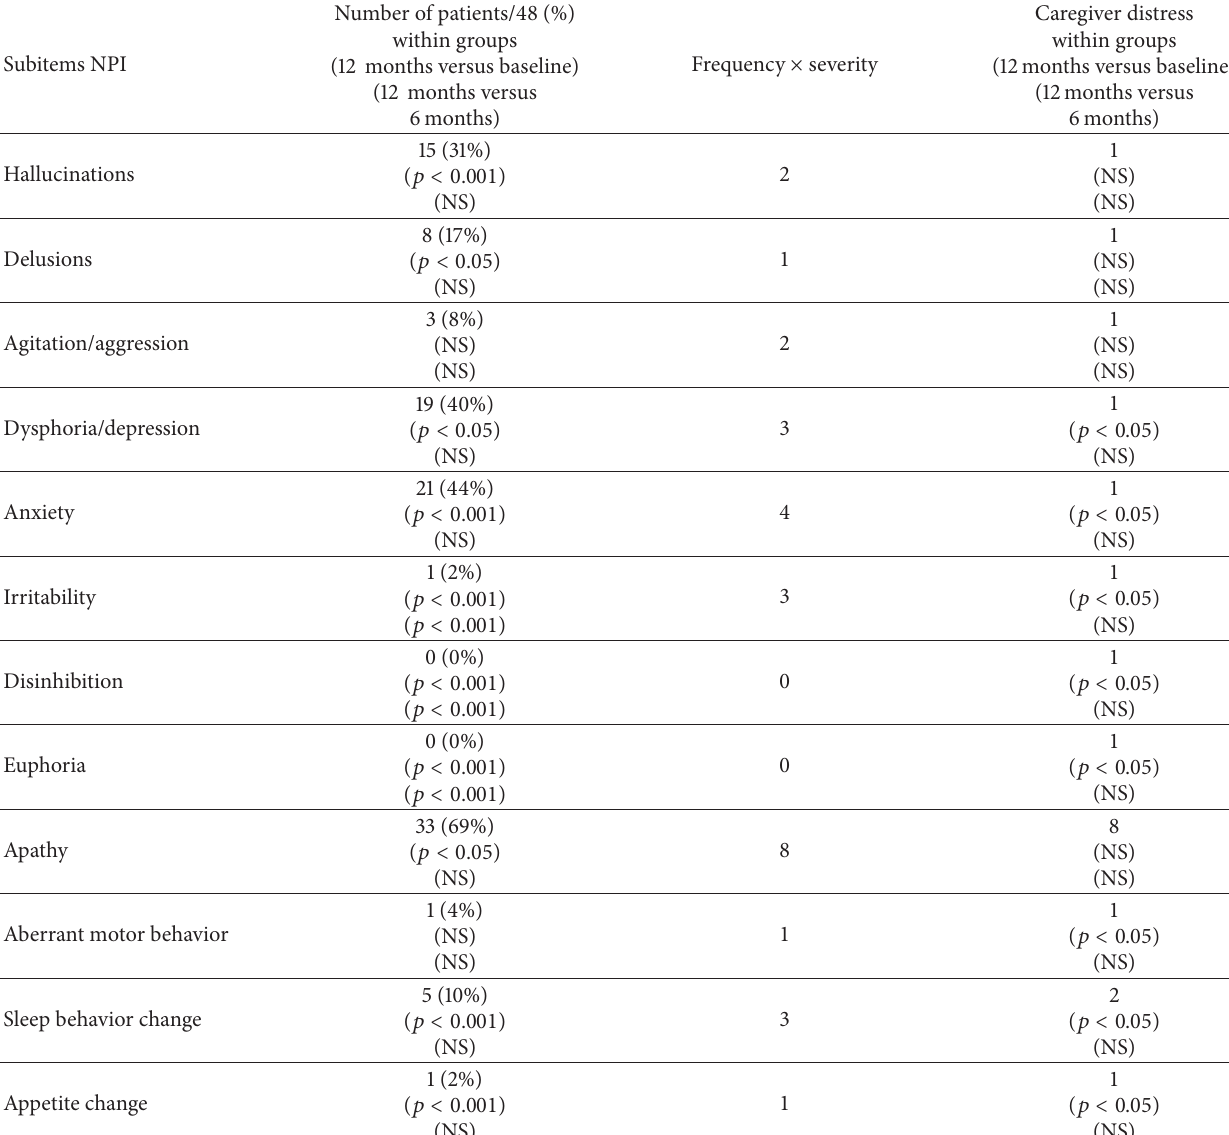
Table 5: 12-month NPI results. In the first and third rows it has been reported the within group comparison with baseline and with 6-month results.